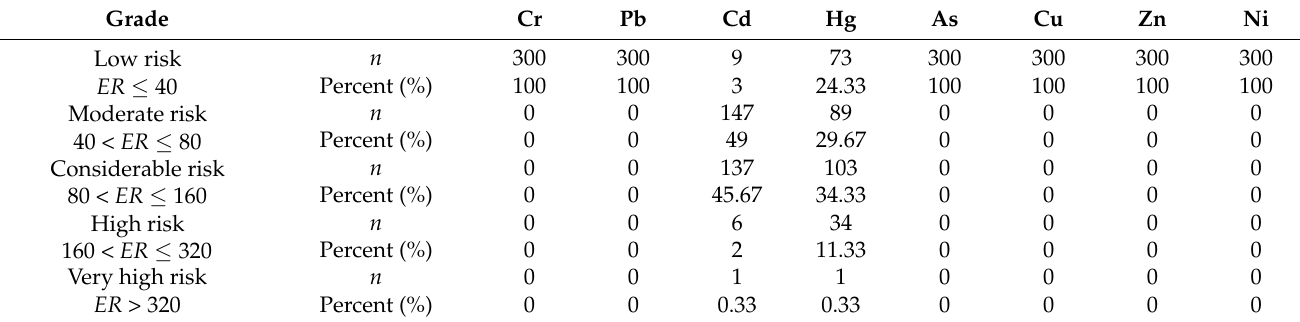
Table 3. Pollution status assessed by potential ecological risk assessment index ( n = 300).